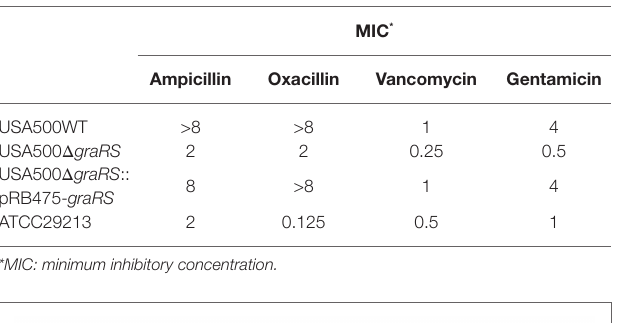
TABLE 4 | The MIC of ampicillin, gentamicin, oxacillin, and vancomycin for different Staphylococcus aureus strains (the broth microdilution method).